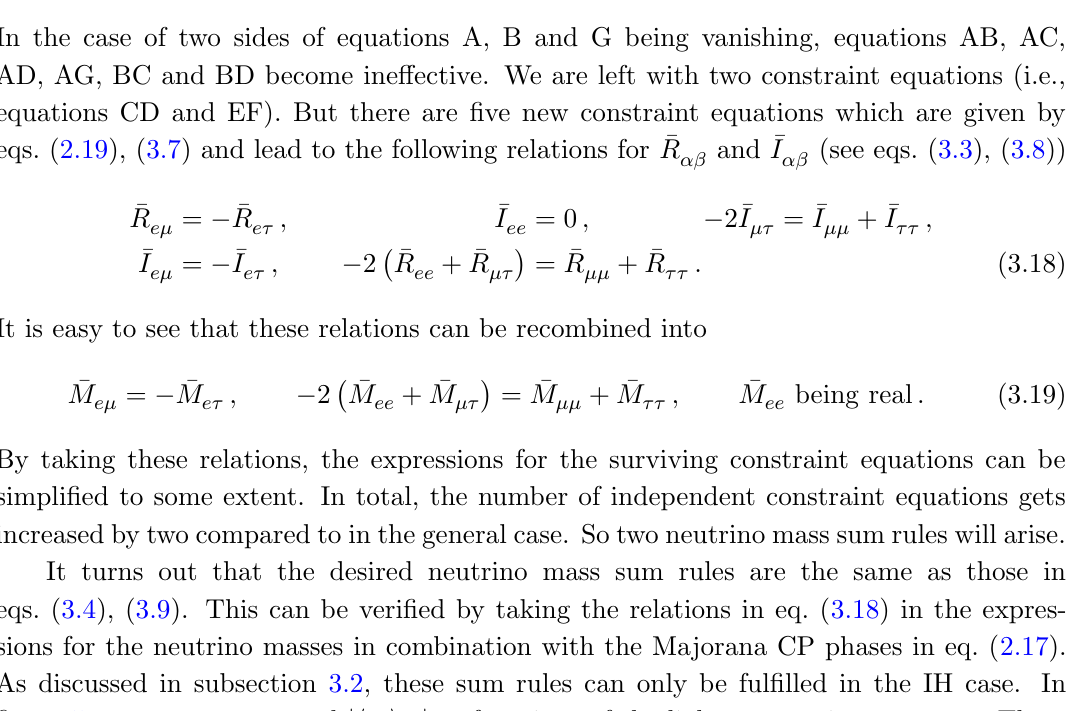
Figure 4 . jh m i j as a function of the lightest neutrino mass ( m ee case) for the possible combinations [ (cid:26); (cid:27) ] = [ (cid:25)= 4 ; (cid:25)= 4] ; [ (cid:25)= 4 ; 3 (cid:25)= 4] ; [3 (cid:25)= 4 ; (cid:25)= 4] and [3 (cid:25)= 4 ; 3 (cid:25)= 4] in the case of two sides of equation D being